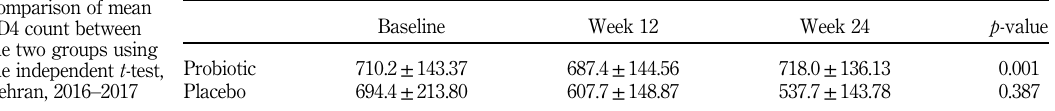
CD4 count between the two groups